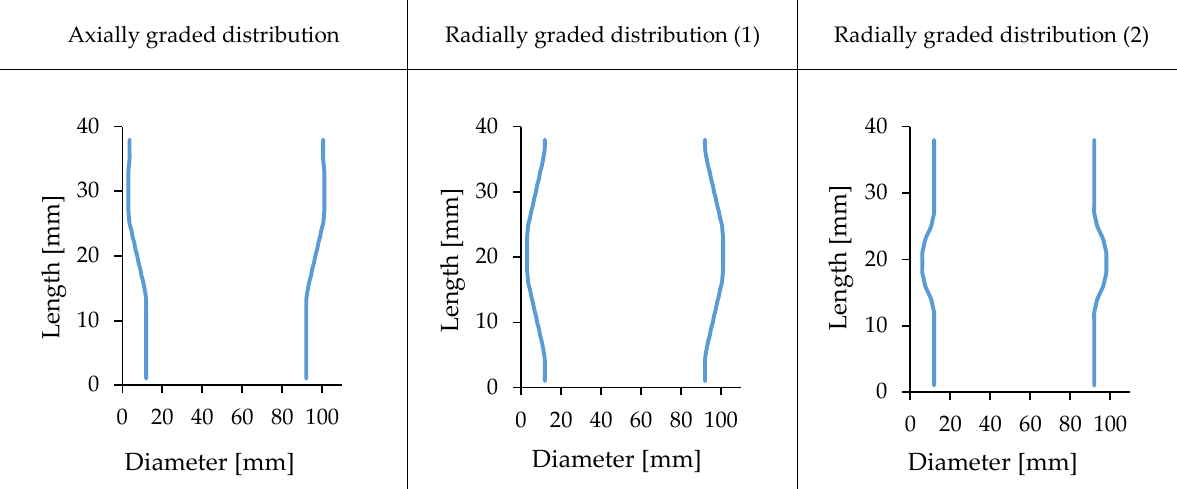
Figure 3. Bulging behavior of the different graded specimen types at the same way of deformation of about 10 mm.